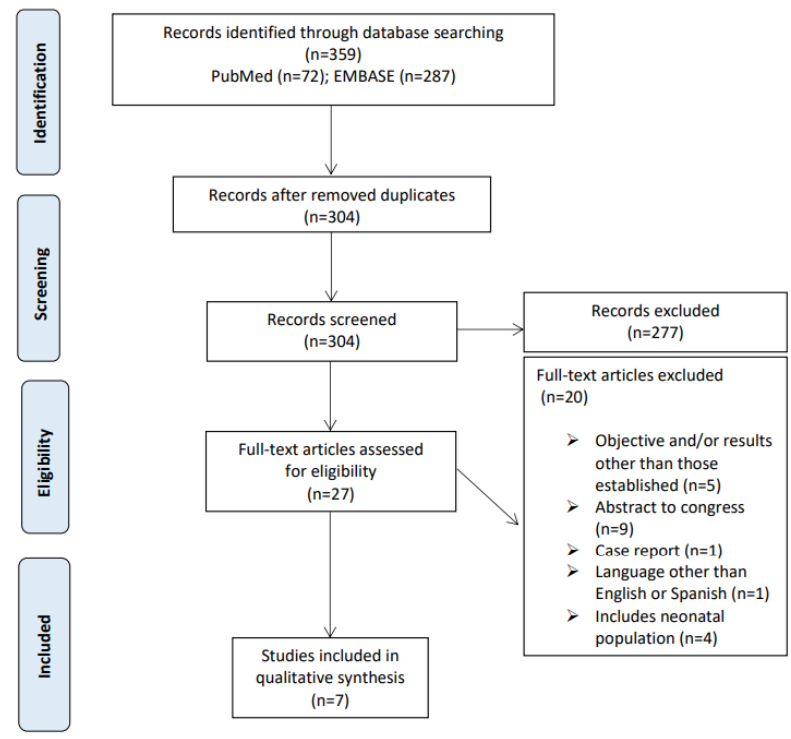
Figure 1. Study selection flowchart.